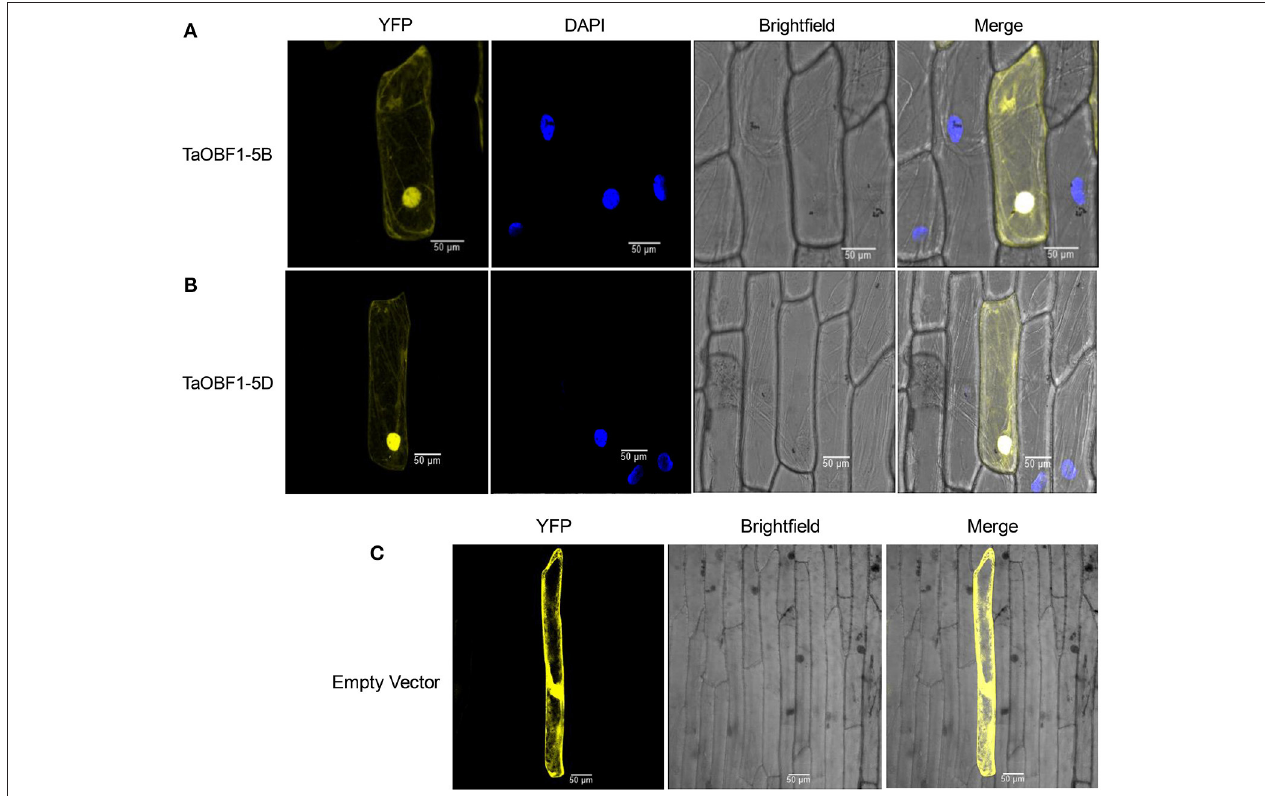
FIGURE 3 | Subcellular localization of selected TaOBF1 homoeologs (A) TaOBF1-5B, (B) TaOBF1-5D, and (C) localization of pSIT3CA empty vector. DAPI stain was used to highlight the nucleus along with the YFP (YFP, yellow fluorescent protein) (scale bar 50 µ m).